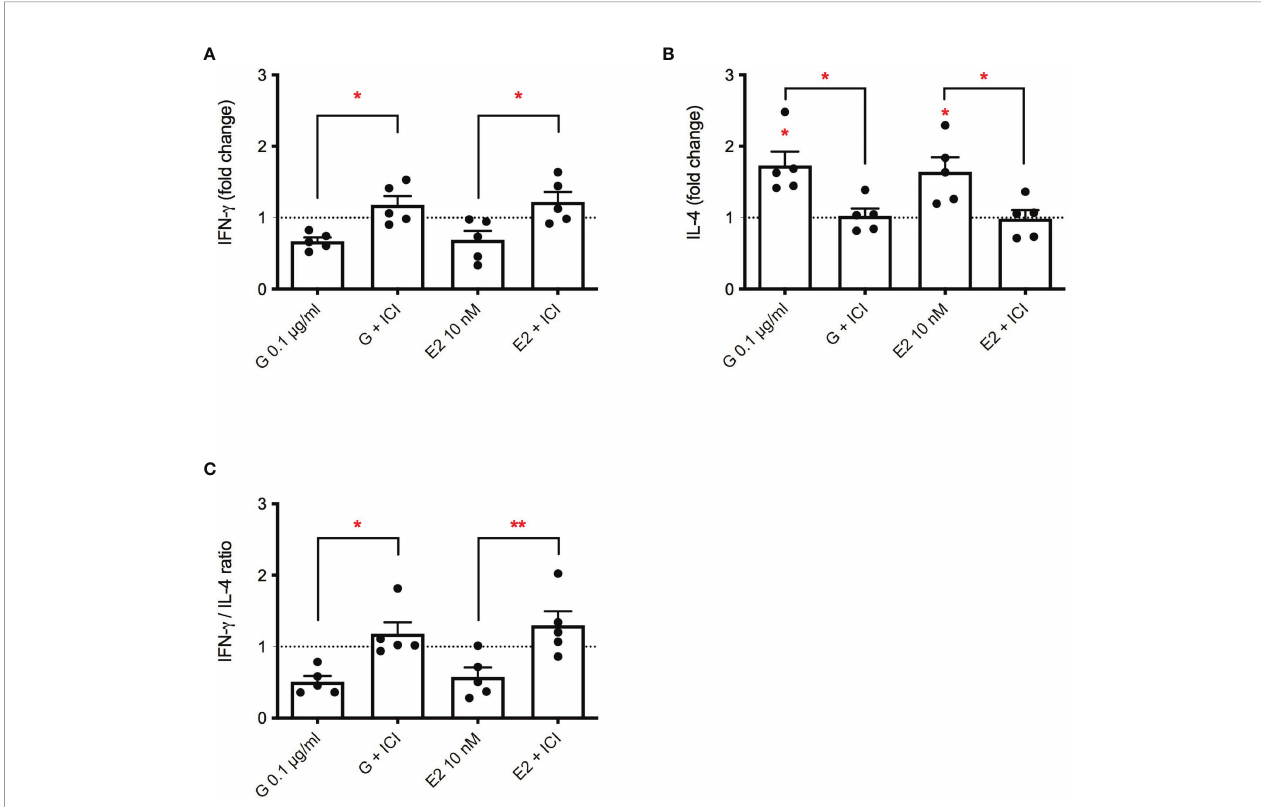
FIGURE 3 | Role of ER a in G-induced cytokine release. PBMC (10 6 /mL) were treated with ICI 182,780 (1 µM) for 15 minutes, and then with G (0.1 µg/mL) or with E2 (10 nM) for 1 h. After that, cells were stimulated with PMA plus ionomycin for 72 h. Cytokines were measured by ELISA in cell-free supernatants. (A) IFN- g release. (B) IL-4 release. (C) IFN- g /IL-4 ratio. Results are expressed as fold-change of the cytokine released in G treated cells versus relative control cells (untreated cells for G- or E2-treated cells and cells treated with ICI for G+ICI- or E2+ICI-treated cells). The dotted line reported is set at 1.0 (control). Each column represents the mean ± SEM, n = 5 donors. Each dot represents the value of the single donor. Statistical analysis was performed with Tukey ’ s multiple comparison test, with * p < 0.05 and ** p < 0.01 vs control untreated cells or the corresponding not ICI-treated cells.